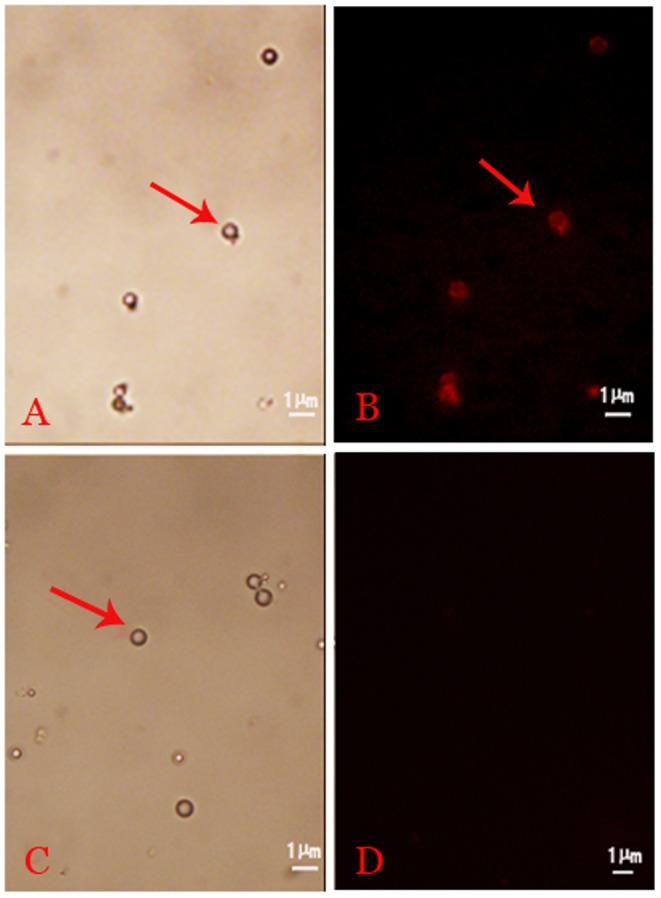
Nanobubbles with Cy3-labeled AR siRNA observed under fluorescence microscopy.(A) PLL nanobubbles under bright-field microscopy. (B) Obvious fluorescence was observed in the PLL nanobubbles. (C) Blank nanobubbles under bright-field microscopy. (D) No fluorescence was observed in the blank nanobubbles. The red arrows in the images indicate nanobubbles (1,000×).